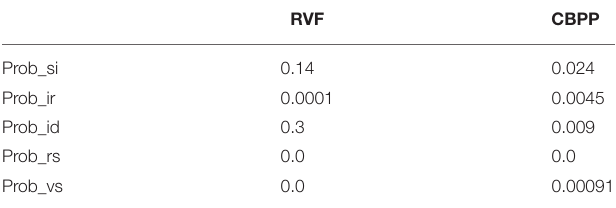
TABLE 1 | Markov transition